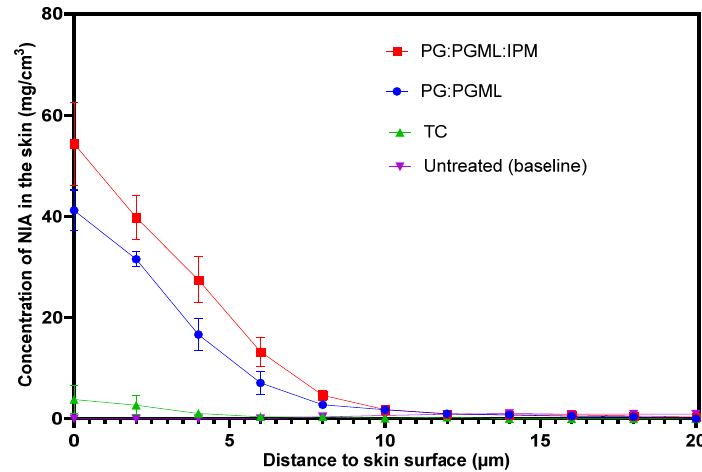
Figure 4. Concentration profiles of NIA (mg / cm 3 ) across the human volar forearm skin as a function of distance to the skin surface following a 60 min application of formulations in vivo ( n = 8; mean ± SEM). The untreated skin served as a baseline and has been subtracted from the other profiles.